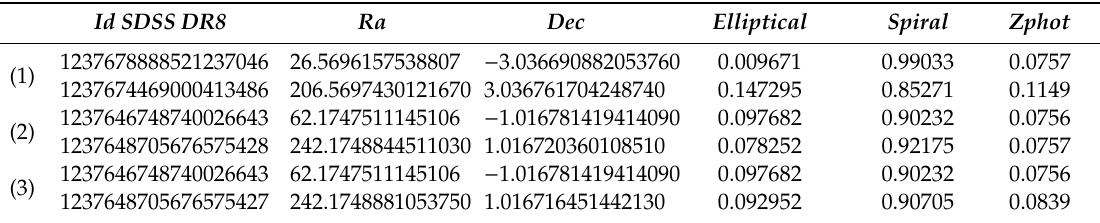
Table 8. Pairs with the best positional accuracy for the e ff ect of cosmic mirror in catalog